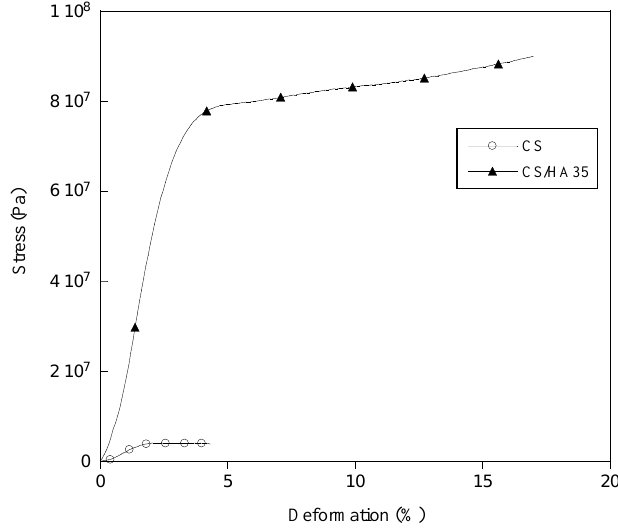
Figure 6. Stress–strain curves for CS and CS/HA35 matrices.